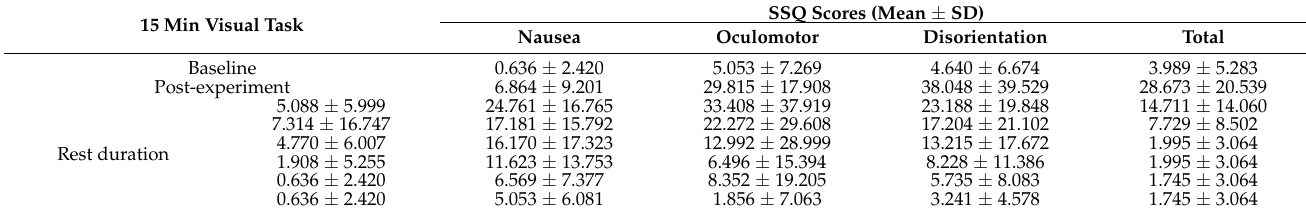
Table 5. Means and standard deviation results for SSQ scores for 30 min visual task baseline, post- experiment, and rest time.